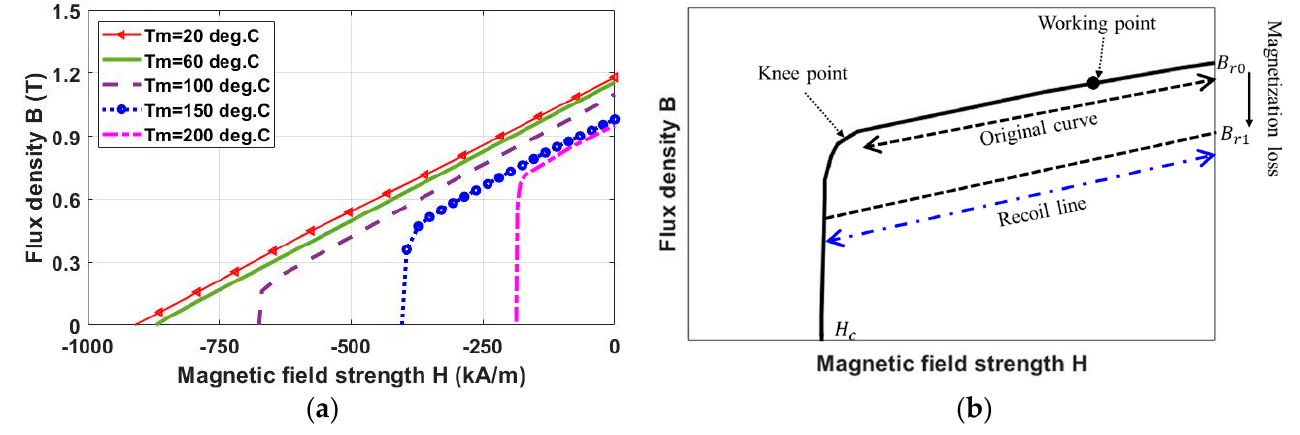
Figure 5. B(H) curves of the used PM material. ( a ) Temperature-dependent B(H) curves and ( b ) reversible and irreversible demagnetizations.